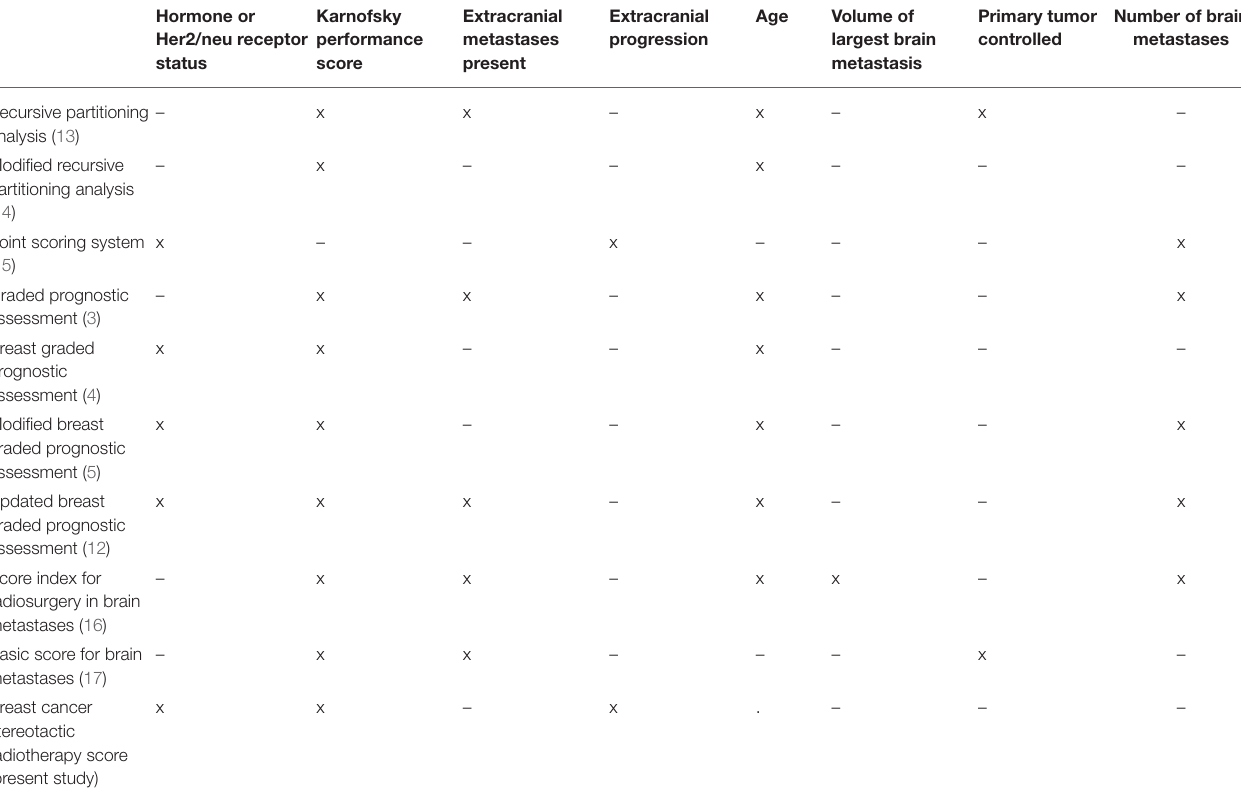
TABLE 1 | Overview of prognostic scoring indexes for radiotherapy in brain metastases (x marks included